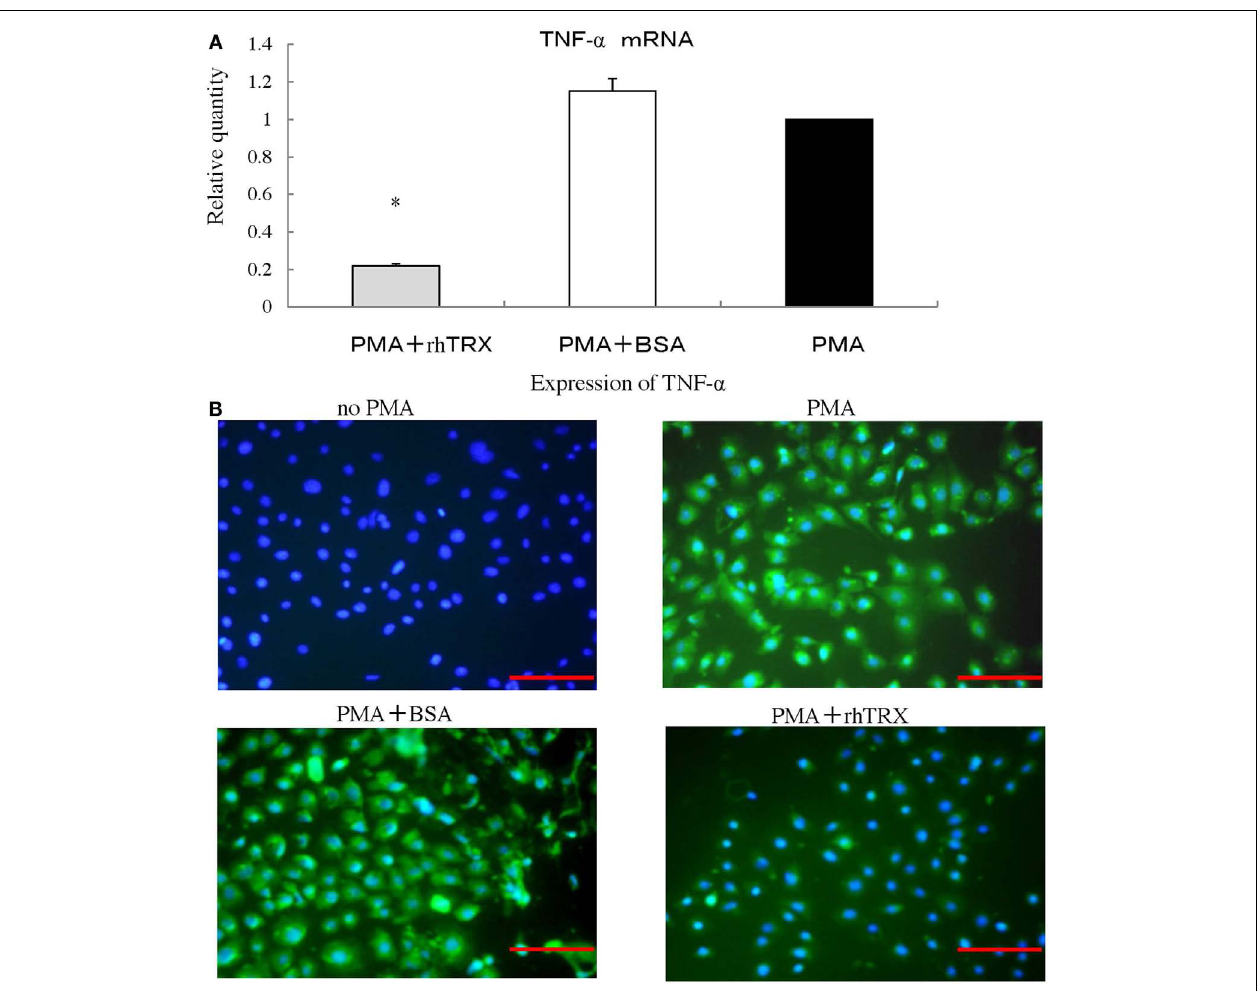
expression levels were determined relative to PMA-stimulated cells.Values are shown as the mean ± SD of two experiments (Student t -test). (B) The expression ofTNF- α in the cells was detected by immunocytochemistry 24h after simulation.The application of 10 µ g/ml rhTRX significantly suppressed the expression ofTNF- α produced by PAM 212 cells stimulated by PMA (expression ofTNF- α , FITC, green; nuclear staining, DAPI, blue). Bars, 100 µ